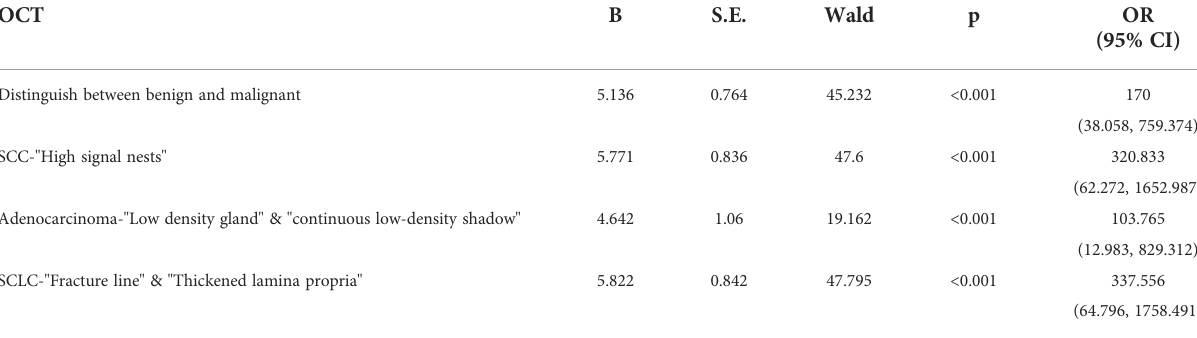
TABLE 2 The logistic regression analysis of the general clinical features and main OCT image characteristics in the differentiation of benign and malignant bronchial lesions and histopathological classi fi cation of lung cancer.